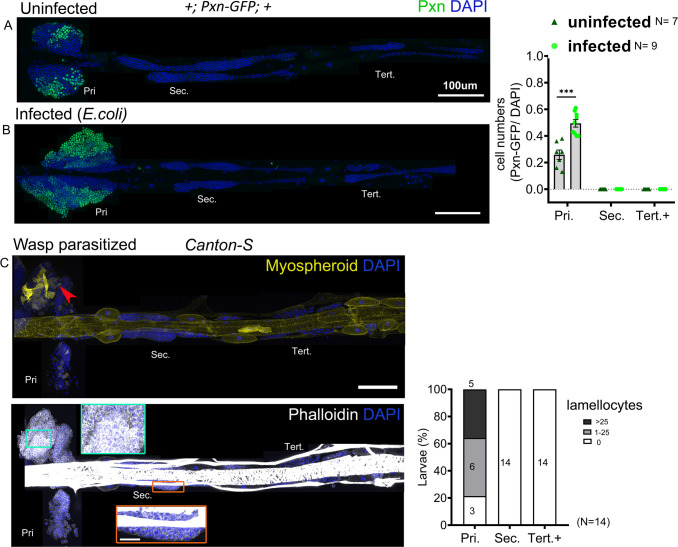
Posterior progenitors (PP) do not differentiate in response to E. coli infection and wasp parasitism.(A and B) Primary lobes show increased expression of Pxn-GFP (green) in response to E. coli infection whereas PP are maintained. Graph indicates ratio of Pxn+/DAPI+ cells. Mann–Whitney nonparametric test was used for statistical analysis and error bars represent SEM. (C) Lymph gland response 2 days post-parasitism by L. boulardi. Immunostaining against the ß-integrin Myospheroid (yellow) reveals lamellocyte differentiation (red arrowhead). Phalloidin (white) marks actin. Green and orange insets: high magnification views of the primary and secondary lobes, respectively. Pri. indicates primary lobes, Sec. indicates secondary lobes, and Tert. indicates tertiary lobes. Graph indicates quantification for lamellocyte induction. ***p<0.001 and ns indicates nonsignificant. (A–C) Scale bar: 100 µm.Figure 4—figure supplement 1—source data 1.Numerical data plotted and statistical analysis related to Figure 4—figure supplement 1.